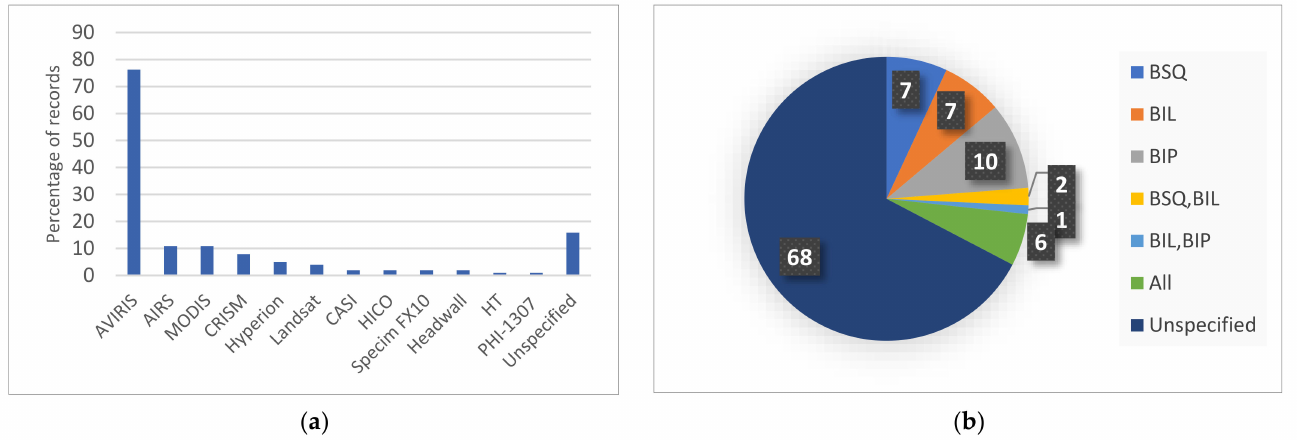
Figure 7. ( a ) Percentage of studies employing each of the different hyperspectral imagers’ datasets. Note that the total number of datasets used is more than the number of records because some of these validated their results using more than one dataset; ( b ) Chart showing the number of studies using each of the scanning order types in HSI